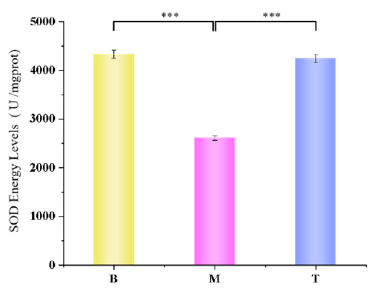
Figure 10. SOD activity value of mouse skin (*** p < 0.001).